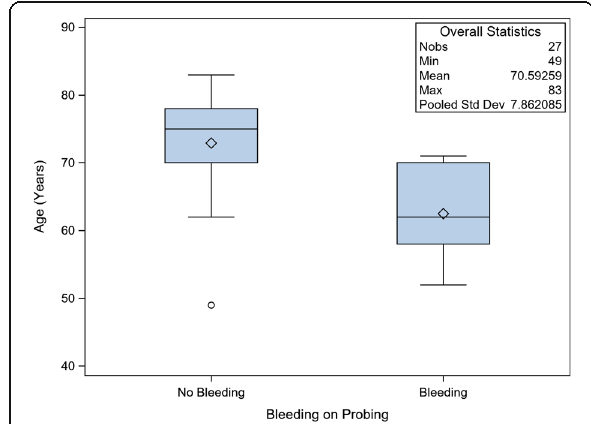
Fig. 5 Distribution of age by bleeding-on-probing. The BOP-positive group was significantly